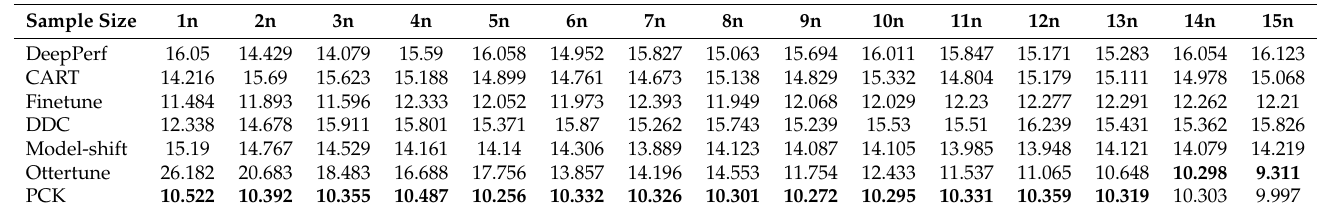
Table 8. MRE comparison among different approaches for MySQL (version 5.7–8.0). Sample Size